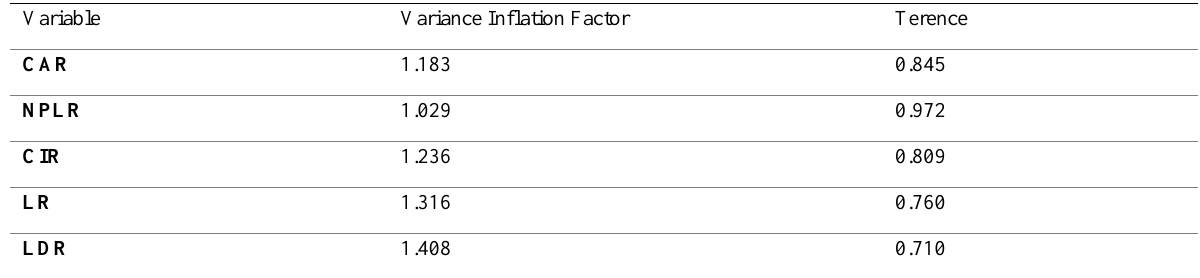
Table 4: Variance Inflation Factor (VIF) - Collinearity